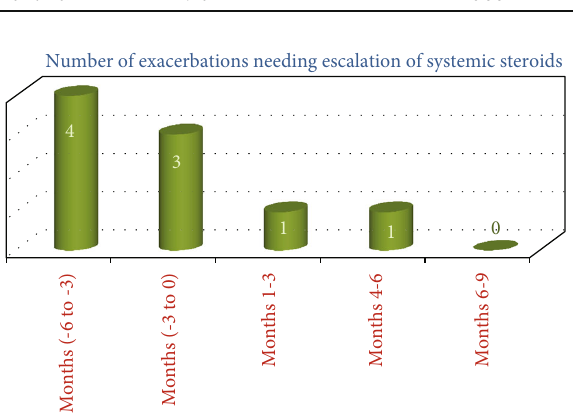
Figure 2: Exacerbations needing escalation of steroid use before and after initiation of anti-IgE